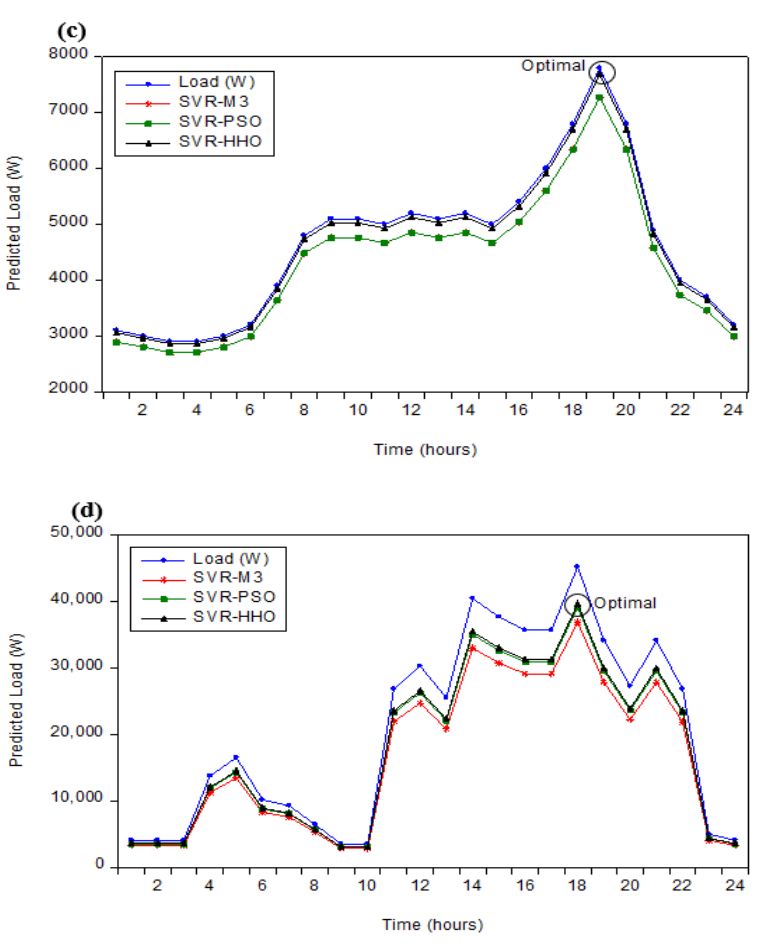
Figure 12. Time series graph of each data index for ( a ) Kano, ( b ) Abuja, ( c ) Niger, and ( d ) Lagos.